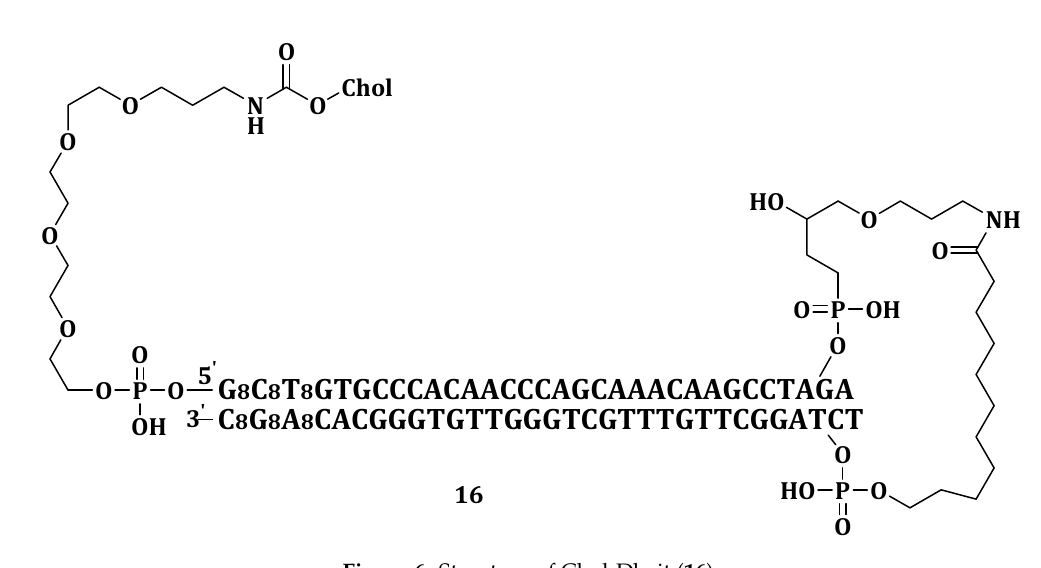
Figure 6. Structure of Chol-Dbait ( 16 ).